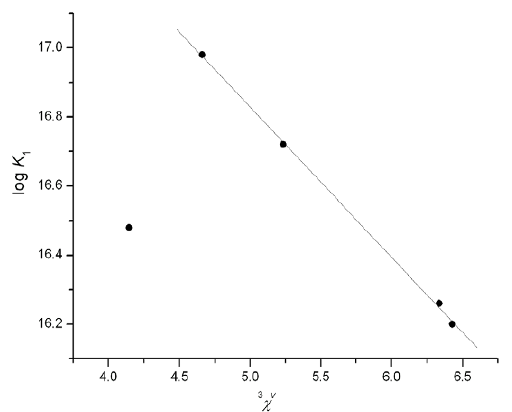
Figure 4. Experimental log K vs. 3 χ v index for Cu(II) 1 N -salicylidene-aminoacidato mono -complexes (Model 3, Table 2; salicylideneglycine was excluded; Cu(II) in salicylidenealanine is tetracoordinated; Cu(II) in salicylideneserine, salicylidenephenilalanine and salicylidenetyrosine is pentacoordinated).